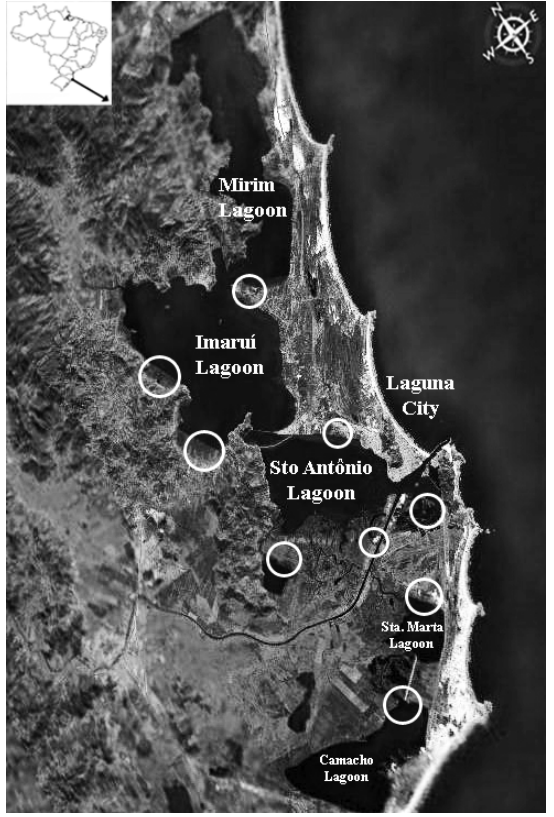
Fig. 1 – Study area. Circles represent researched